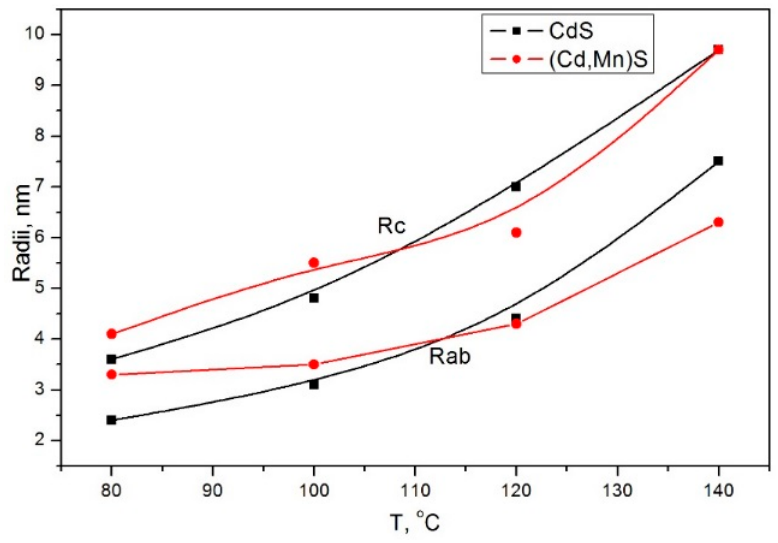
Figure 6. Dependence of radii Rab (in ab plane) and Rc (along c direction) of ellipsoidal particles on temperature T.